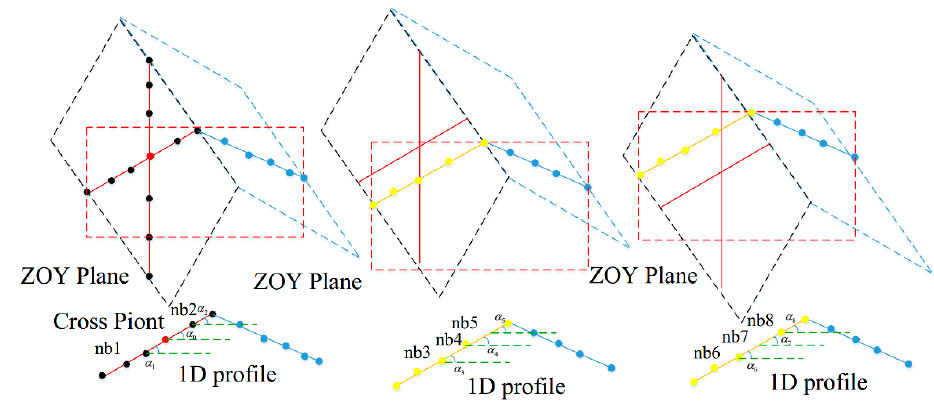
Figure 3. Seed CLE and neighbors of the cross-point.